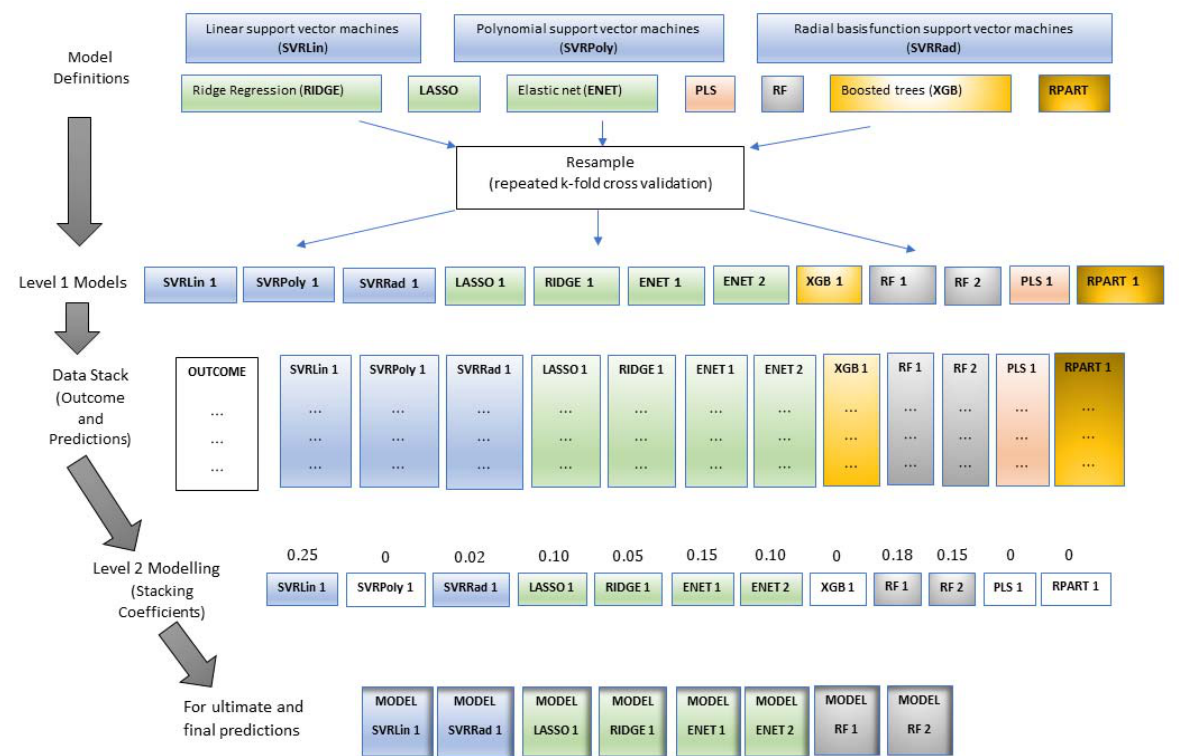
Figure 1. The visual outline of the steps in stack regression. The models were first defined in which each Level 1 model has different parameter values. The models with different configurations were then stacked together and a regularized model was then fitted on each of the candidate members to determine which members have non ‐ zero coefficients that are to be used for final and ultimate pre ‐ dictions (SVRLin = support vector regression with linear kernel; SVRPoly = support vector regres ‐ sion with polynomial kernel; SVRRad = support vector regression with radial kernel; LASSO = least absolute shrinkage and selection operator; RIDGE = ridge regression; ENET = elastic net regression; PLS = partial least squares; RF = random forests; RPART = recursive partitioning and regression trees; XGB = boosted trees) [48].